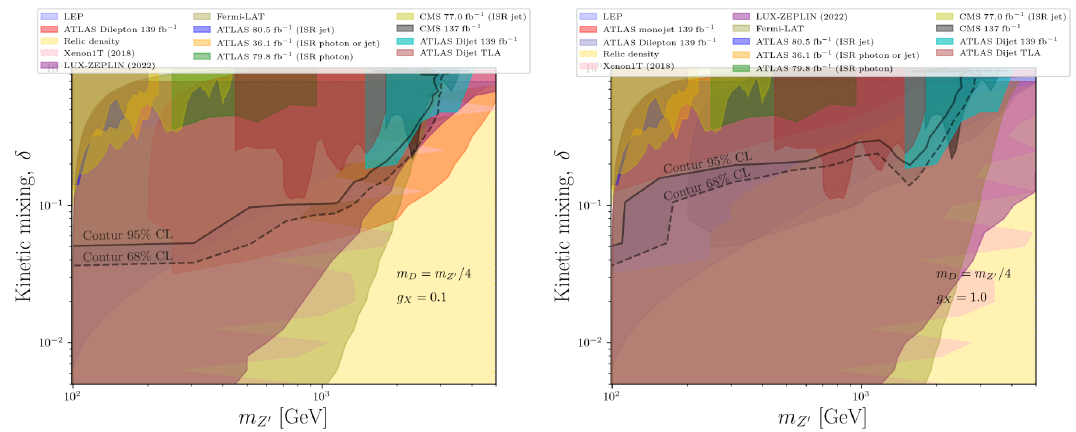
Figure 3 . Limits from DM direct and indirect detection experiments, relic density and LHC constraints from ATLAS dilepton, dijet and monojet searches at 139 fb − 1 for m D = m Z 0 / 4 and g X = 0 . 1 (left panel) and g X = 1 . 0 (right panel). The 95% CL and 68% CL contours from Contur and LEP constraint are also